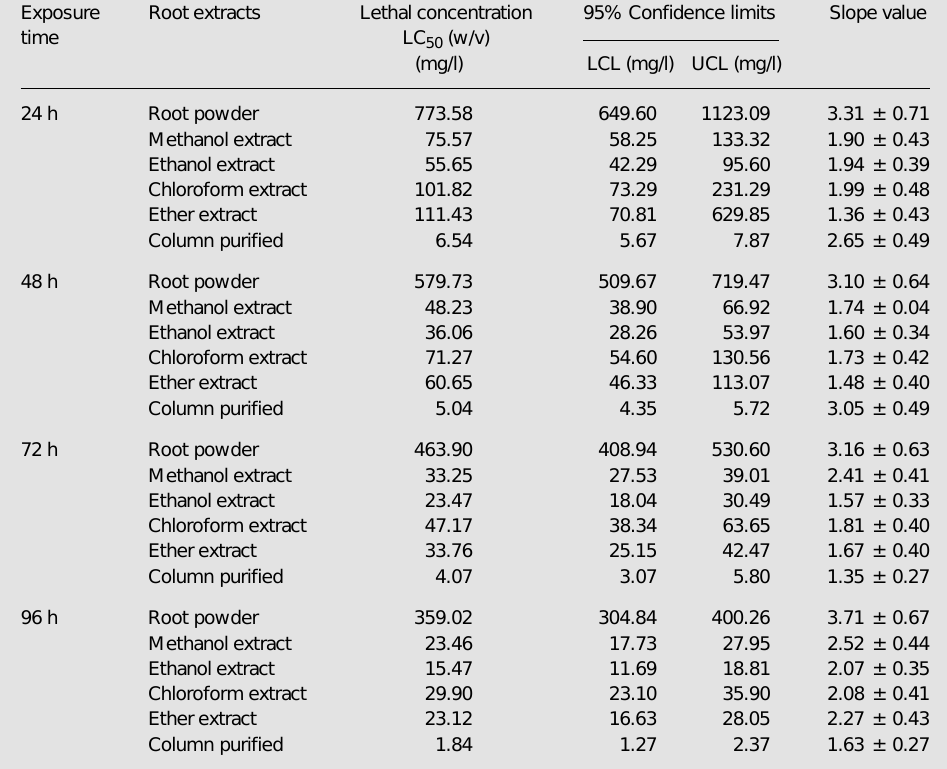
Table 1 - Toxicity (LC 50 ) of extracts of Canna indica root against the snail Lymnaea acuminata. Batches of 10 snails were exposed to different concentrations of the extract. Mortality was determined every 24 h. Each set of experiments was replicated six times. The values are the final concentrations (mg/l) in the aquarium water. The t-ratio was >1.96, the heterogeneity factor <1.0, and the g value <0.5 at all probability levels. LCL, Lower confidence limit; UCL, upper confidence limit. The slope value is reported as mean ± SEM. Significant negative regression (P<0.05) was observed between exposure time and LC 50 of treatments. Testing significance of regression coefficient - root powder, 9.15 + ; methanol extract, 10.02 ++ ; ethanol extract, 7.31 ++ ; chloroform extract, 11.42 + ; ether extract, 11.50 + ; column purified, 8.79 + . + Linear regression between x and y; ++ nonlinear regression between log x and log